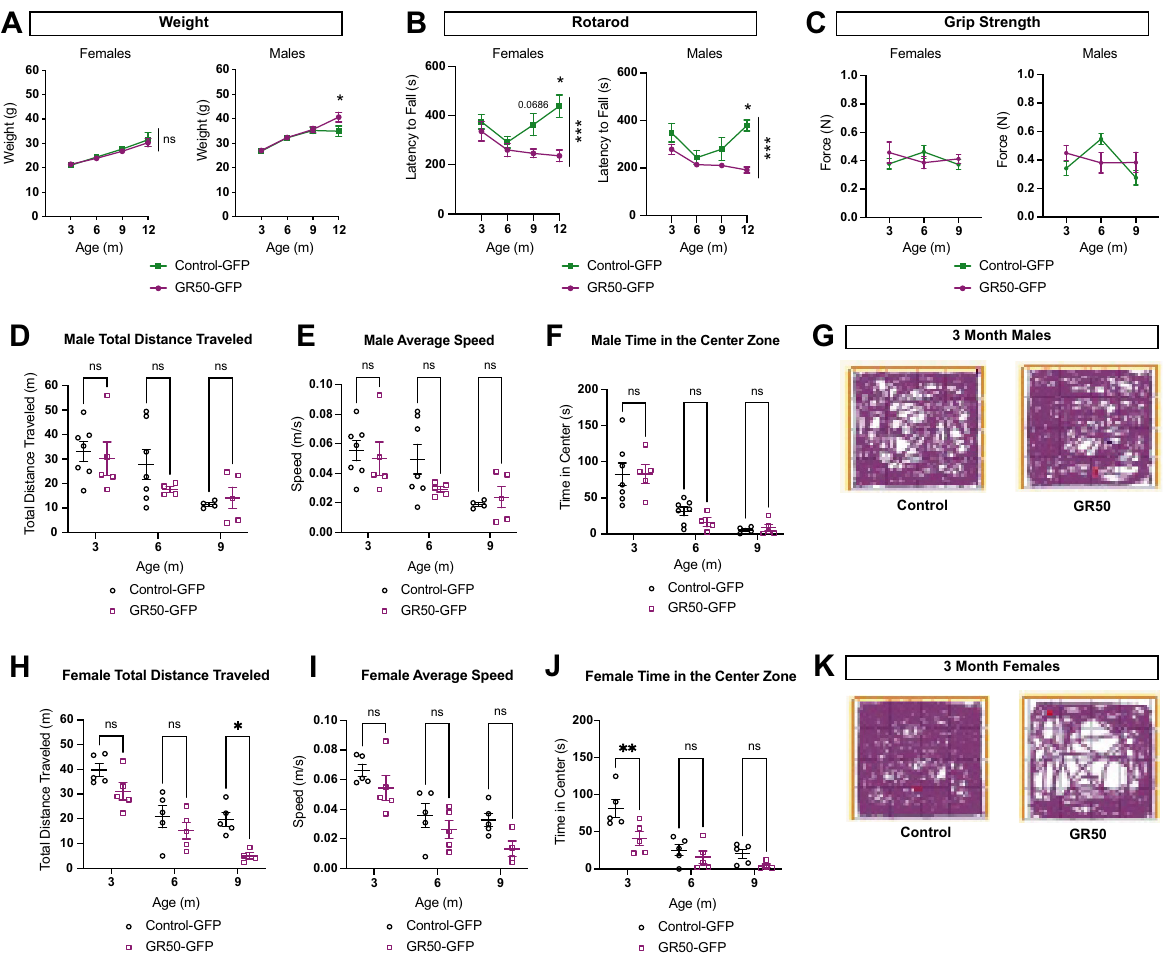
Figure 6. Motor and behavioral phenotypes in GR50 expressing mice. ( A ) Weight of female (left) and male (right) control-GFP and GR50-GFP mice at 3, 6, 9, and 12 months. Females: control-GFP n = 15, 15, 13, 6; GR50-GFP n = 14, 11, 11, 6. Males: control-GFP n = 12, 13, 11, 5; GR50-GFP n = 14, 11, 11, 6. Mean ± s.e.m. Females: 3-months p = 0.9945, 6-months p = 0.9934, 9-months p = 0.9184, 12-months p = 0.9373. Males: 3-months p = 0.9997, 6-months p > 0.9999, 9-months p = 0.9976, 12-months p = 0.0473. ( B ) Rotarod performance of female (left) and male (right) control-GFP and GR50-GFP mice at 3, 6, 9, and 12 months. Females: control- GFP n = 14, 9, 9, 4; GR50-GFP n = 14, 11, 11, 6. Males: control-GFP n = 12, 13, 10, 5; GR50-GFP n = 10, 9, 8, 3. Mean ± s.e.m. Females: 3-months p = 0.8103, 6-months p = 0.9430, 9-months p = 0.0686, 12-months p = 0.0177. Males: 3-months p = 0.1998, 6-months p = 0.8804, 9-months p = 0.3002, 12-months p = 0.0117. ( C ) Hindlimb grip strength measurements of female (left) and male (right) control-GFP and GR50-GFP mice at 3, 6, and 9 months. Females: n = 5 per genotype; Males: n = 7 control-GFP, 5 GR50-GFP. Mean ± s.e.m. Females: time x genotype p = 0.4314. Males: time x genotype p = 0.5490. ( D ) Male total distance traveled in Open Field Assessment. Control-GFP n = 7, 7, 4; GR50-GFP n = 5, 4, 5. Mean ± s.e.m. 3-months p = 0.9654, 6-months p = 0.4424, 9-months p = 0.9810. ( E ) Male average speed in Open Field Assessment. Control-GFP n = 7, 7, 4; GR50-GFP n = 5, 5, 5. Mean ± s.e.m. 3-months p = 0.9535, 6-months p = 0.2208, 9-months p = 0.9759. ( F ) Male time spent in the center zone in Open Field Assessment. Control-GFP n = 7, 7, 4; GR50-GFP n = 5, 4, 5. Mean ± s.e.m. 3-months p > 0.9999, 6-months p = 0.7245, 9-months p = 0.9974. ( G ) Representative track plots of male control-GFP and GR50-GFP mice at 3-months. ( H ) Female total distance traveled in Open Field Assessment. Control-GFP n = 5, 5, 5; GR50-GFP n = 5, 5, 4. Mean ± s.e.m. 3-months p = 0.1890, 6-months p = 0.5160, 9-months p = 0.0158. ( I ) Female average speed in Open Field Assessment. Control-GFP n = 5, 5, 5; GR50-GFP n = 5, 5, 4. Mean ± s.e.m. 3-months p = 0.4798, 6-months p = 0.6563, 9-months p = 0.1392. ( J ) Female time spent in the center zone in Open Field Assessment. Control-GFP n = 5, 5, 5; GR50-GFP n = 5, 5, 4. Mean ± s.e.m. 3-months p = 0.0056, 6-months p = 0.8140, 9-months p = 0.4907. ( K ) Representative track plots of female control-GFP and GR50-GFP mice at 3-months. For all datasets, Two-way ANOVA with Sidak’s multiple comparisons test was used for statistical